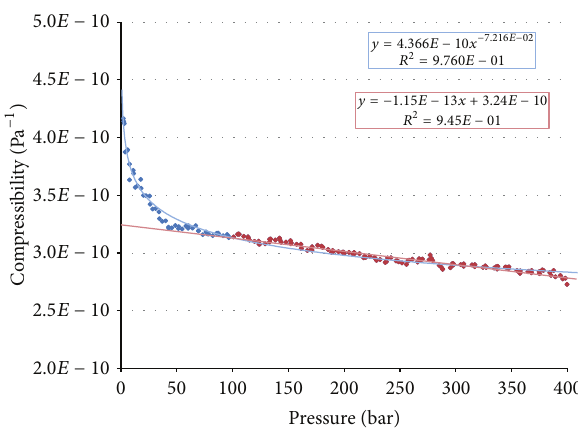
Figure 7: Measured compressibility versus pressure for all three considered